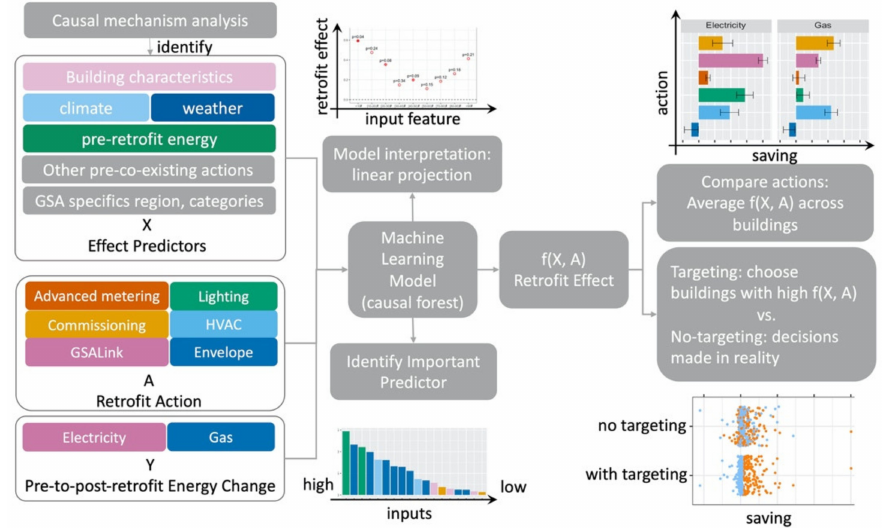
Figure 1. Methodology diagram.